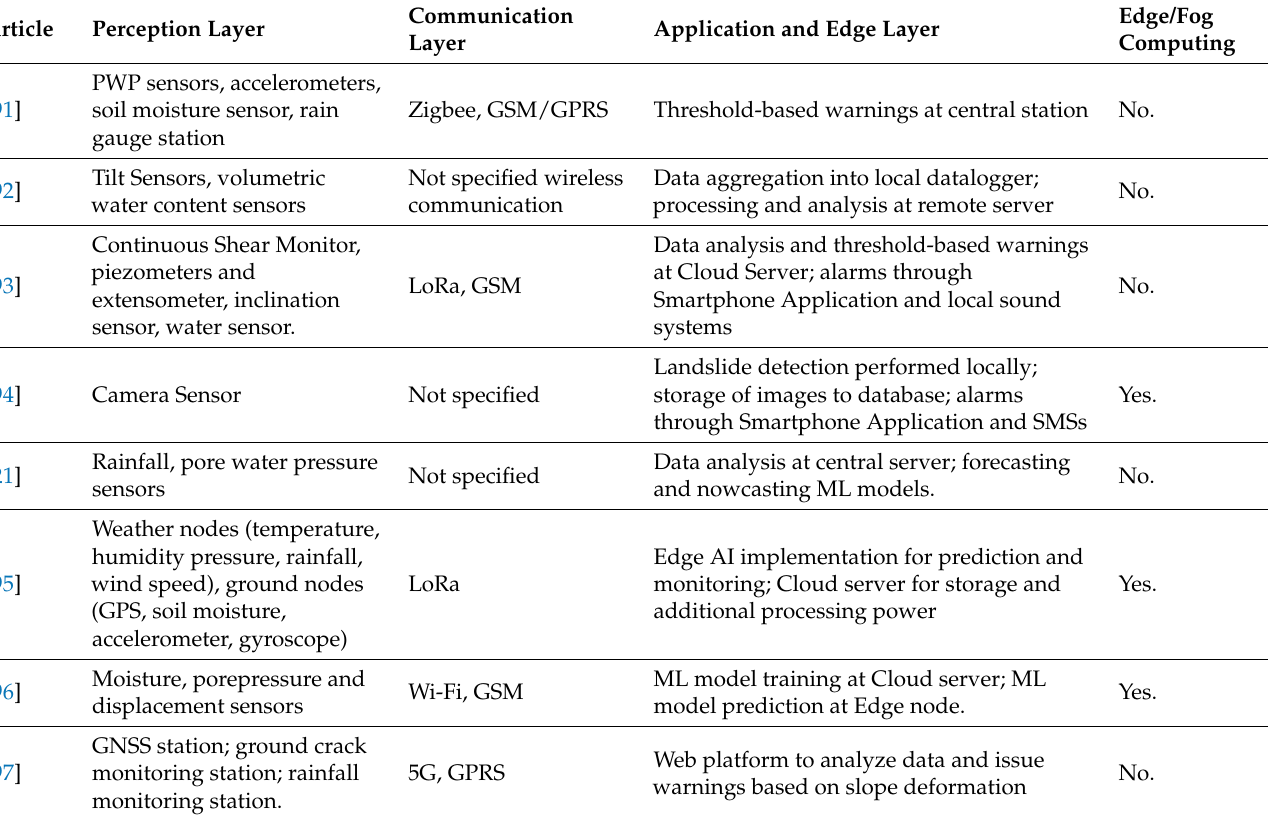
Table 8. Technologies and solutions used for each layer of the reviewed papers for Landslide